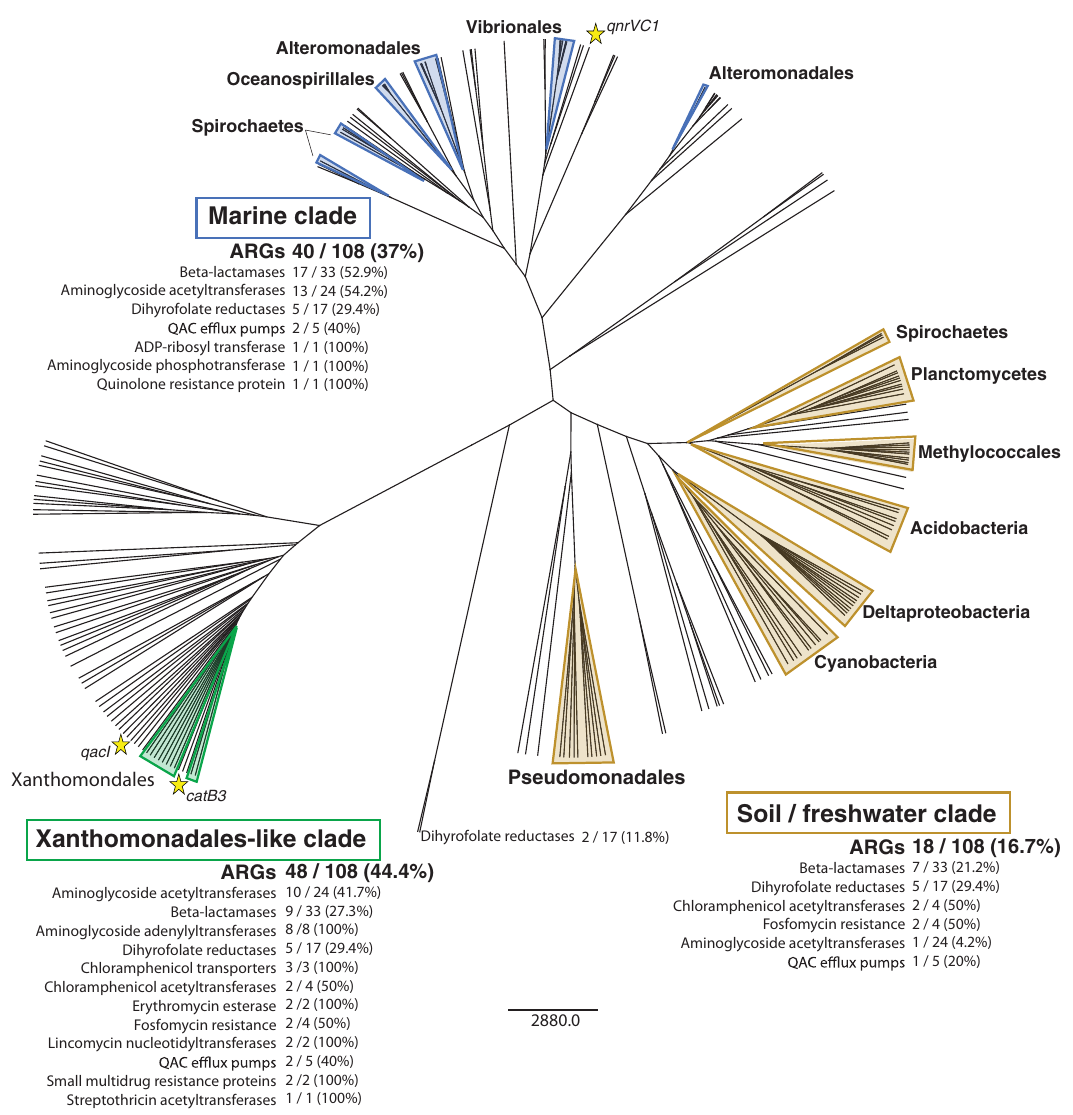
Fig. 2 Structure-based clustering of attC s. Ten top-scoring (based on covariance model (CM) bit scores) attC s for each taxon-speci fi c CM are outlined by shaded triangles. Each non-shaded branch represents an attC site from one of 108 different resistance gene cassettes annotated by Partridge et al. 10 . The structures of attC s cluster according to host environment, forming three major clades. For each clade, the abundance of each resistance type is displayed, along with its relative proportion among all cassettes of that resistance type. Branches with yellow stars represent attC s from the three gene cassettes observed residing in the sedentary chromosomal integrons of the ancestral taxa predicted by our covariance models. We predicted that two of these ( qacI and catB3 ) originated in Xanthomonadales, and the third ( qnrVC1 ) in Vibrionales. Relative distances show all three are highly similar to their predicted taxa, further validating these predictions. See Supplementary Figure 1 for a tree with all branches